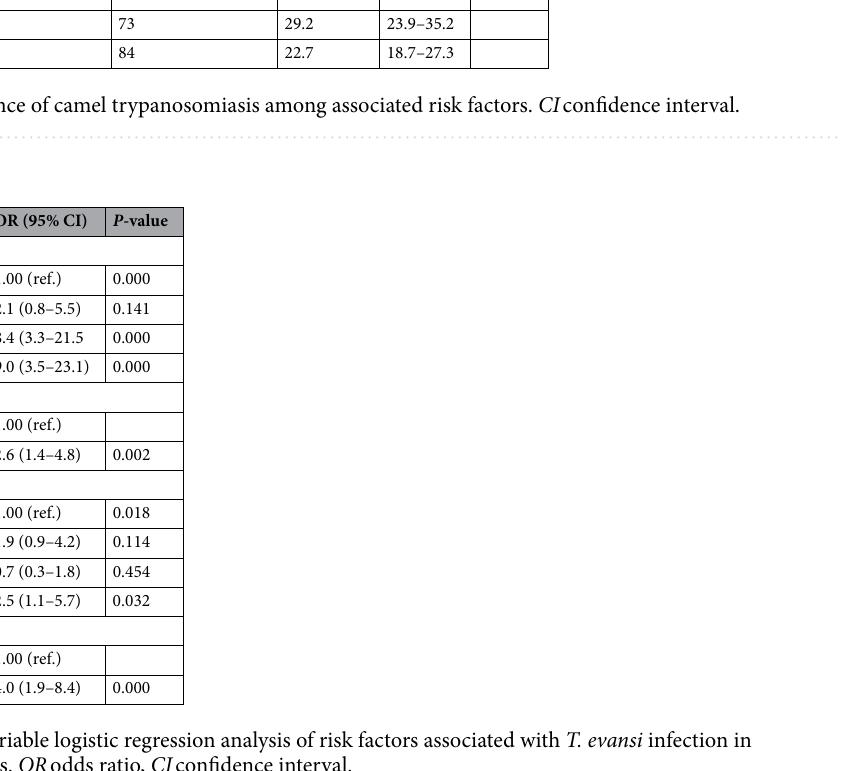
season. Table 2 lists the variables that were kept in the final multivariable model. The risk of T. evansi infection in camel aged > 6 to 10 years and > 10 years were eight and nine times higher, respectively, compared to younger camels (1–3 years-old). Female camels were 2.6 times more likely than male camels to be infected with T. evansi . Furthermore, camels with poor BCS and sampled on spring were 4 and 2.5 times more likely to be T. evansi infected compared to camels with good BCS and sampled on autumn, respectively. The test characteristics of TBS and CATT for detection of T. evansi infection in camels were evaluated against PCR results (Table 3). The CATT showed higher Se (0.83; 95% CI: